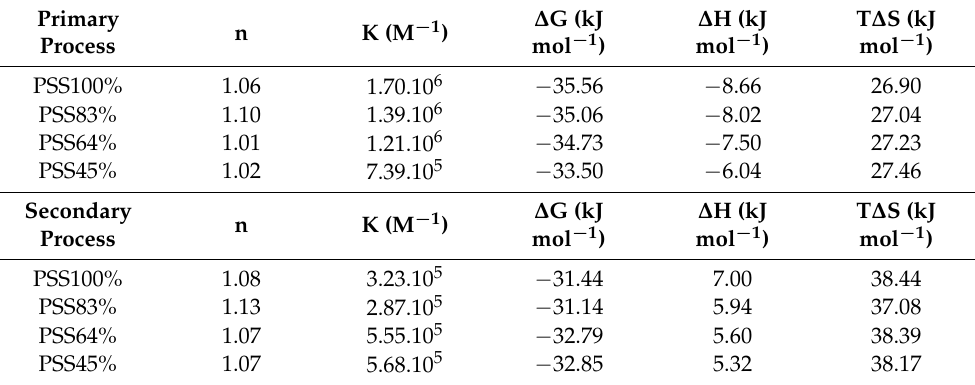
Table 2. Thermodynamic parameters of the primary and secondary process obtained for the complex- ation of P(St-co-SSNa) by PDADMAC at 25 ◦ C. n, K, ∆ G, ∆ H, and T ∆ S correspond to the reaction stoichiometry, the binding constant, the free energy change, the enthalpy change, and the entropy contribution to the free energy. The mole refers to the monomer unit of PDADMAC (titrant).